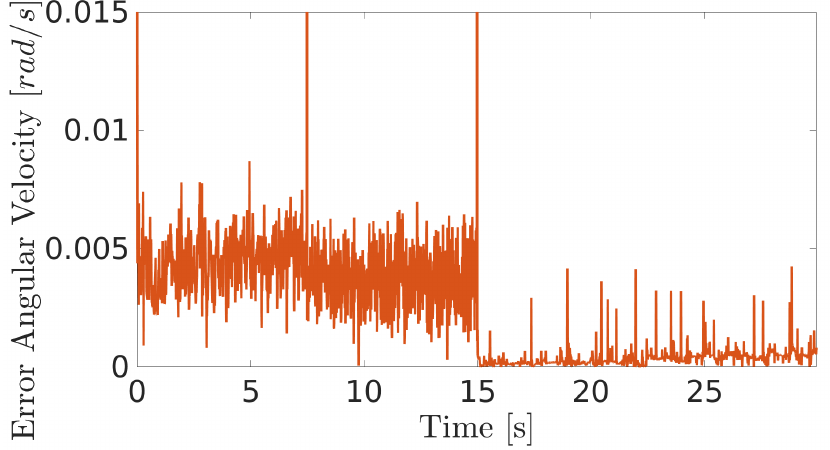
Figure 11. Angular velocity error during navigation of the climbing robot in the storage tank.